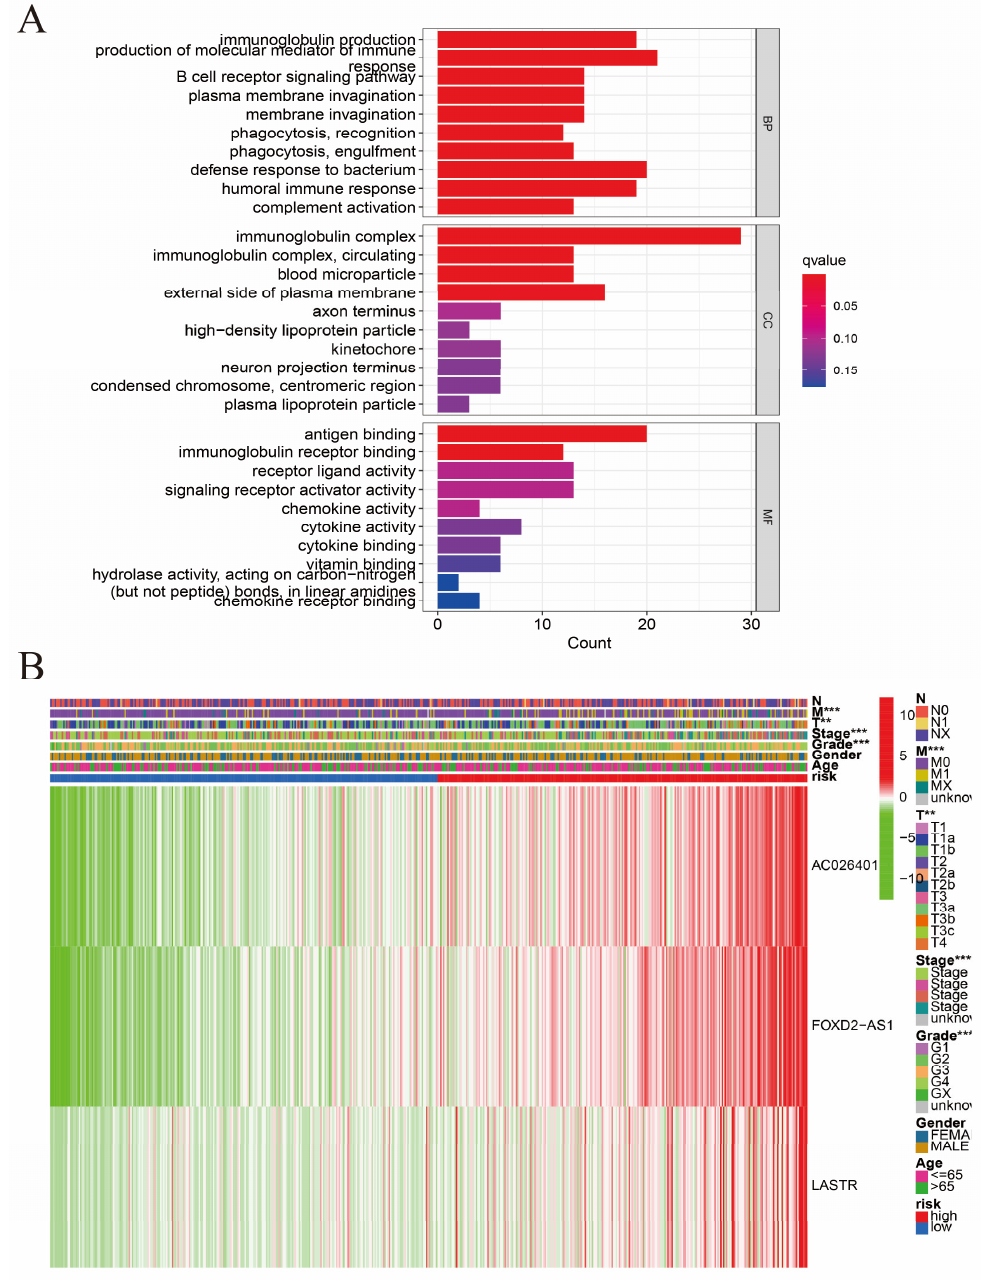
Figure 5. Enrichment analysis for CRLRs obtained from GO and correlation analysis. ( A ) GO enrichment analysis. ( B ) Heatmap of clinicopathological and biological characteristics of two different risk group subtypes of samples divided by the CRLR model. Differences in clinicopathologic features and expression levels of CRLRs between the two different risk groups. Red represents the high-risk group and blue represents the low-risk group. High lncRNA expression levels are shown in red and low lncRNA expression levels are shown in green. The three CRLRs showed a high expression trend in the high-risk group. CRLRs, cuproptosis-related lncRNAs. (** p < 0.01, *** p <